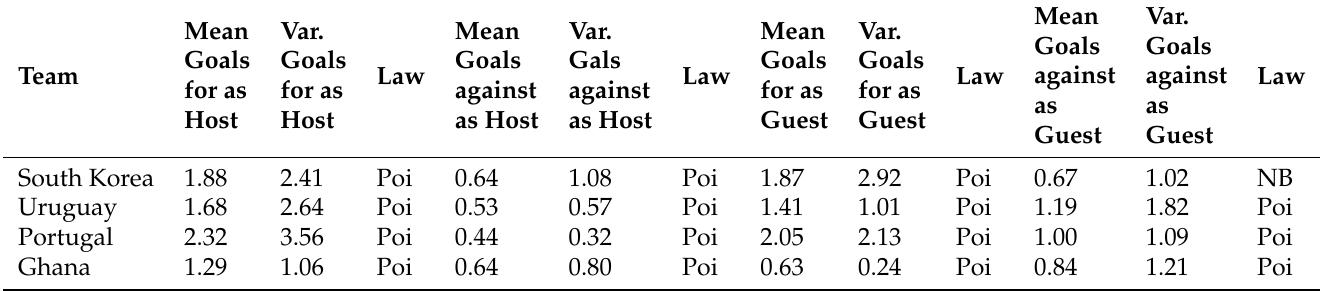
Table 26. Group H in Qatar